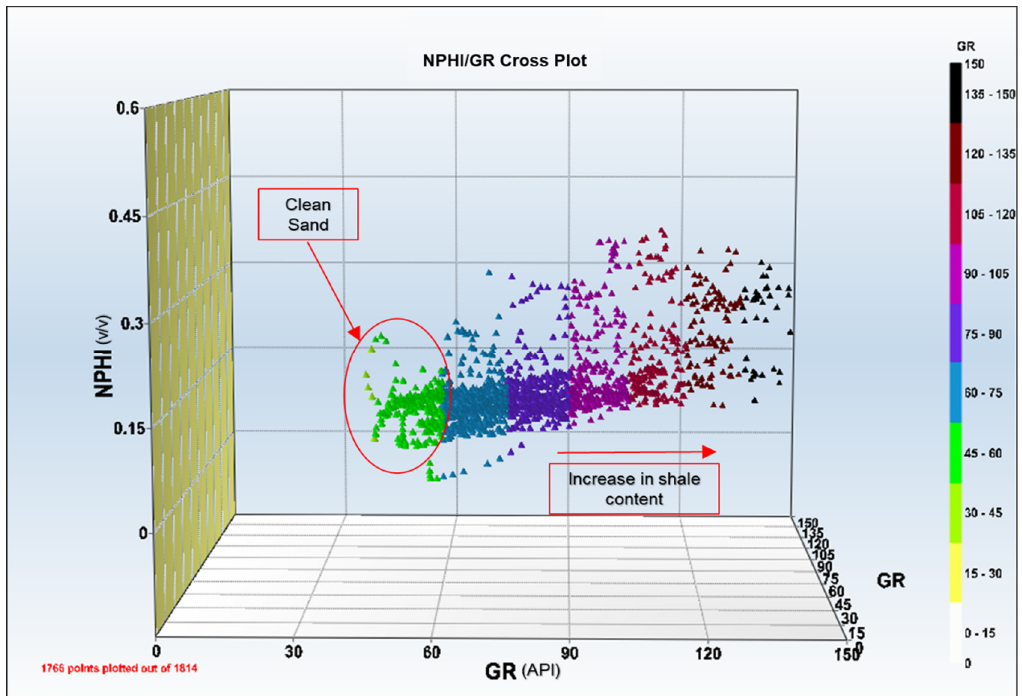
Figure 8. Neutron (NPHI)/Gamma-ray (GR) cross plot for multi-well analysis with discriminator gamma-ray response. Data falling in the black circle indicate clean sandstone.